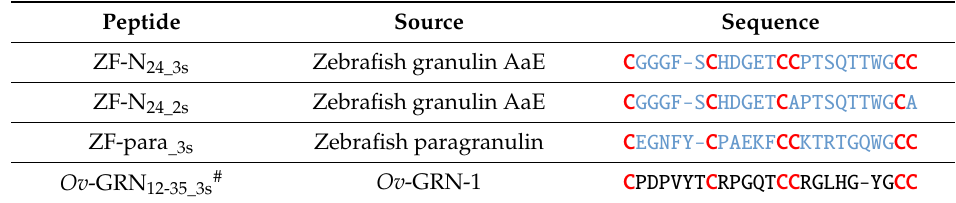
Table 1. Granulin-derived peptide